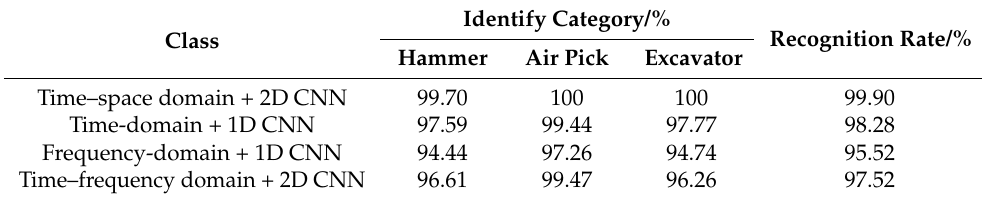
Table 1. The event classification accuracy of